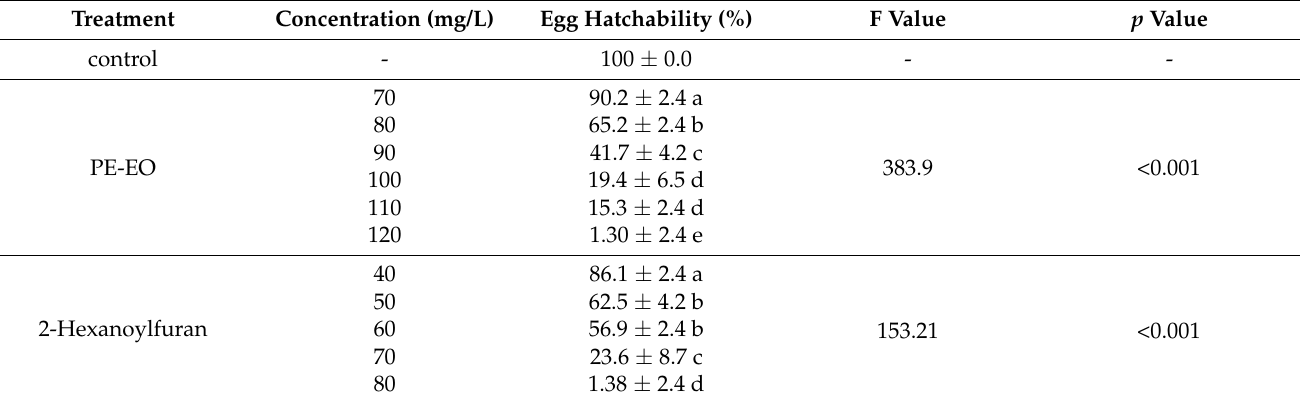
Table 2. Ovicidal activity of Perilla essential oil (PE-EO) and 2-hexanoylfuran against Culex pipiens pallens .